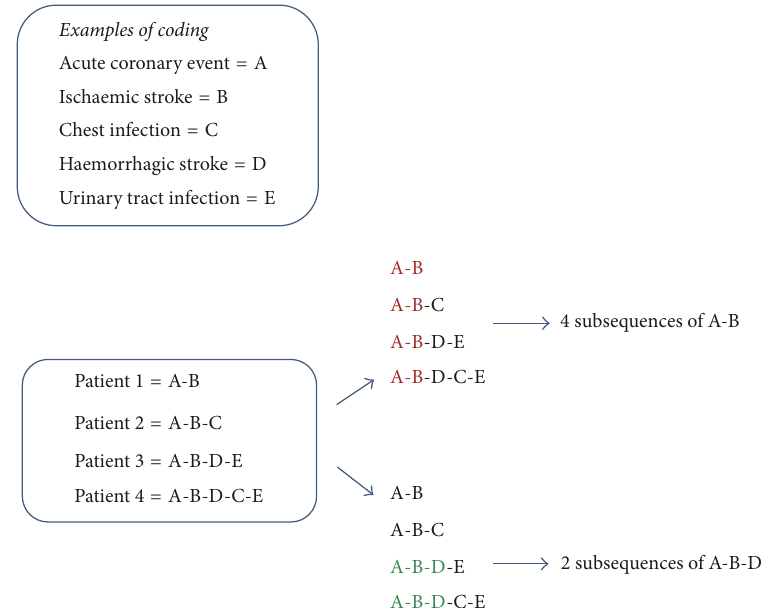
Figure 1: Example of mining of sequence data to identify common subsequences in patient